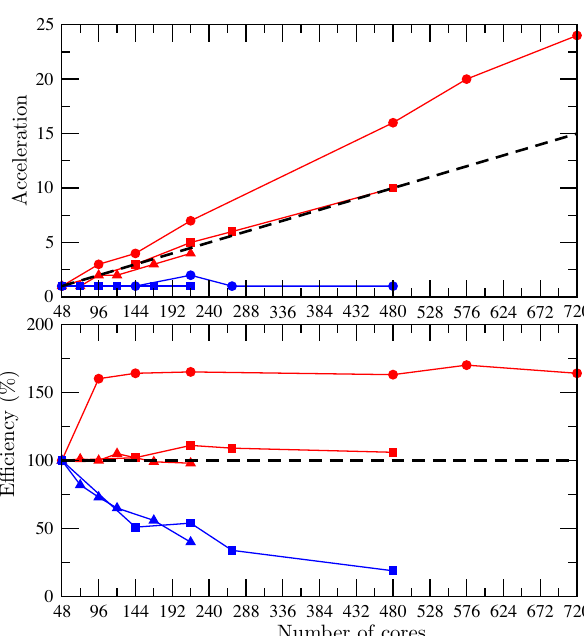
Fig. 3. Acceleration (top) and efficiency (bottom) for strong scalability experiments using the block preconditioner for meshes with (red • ) 2 . 400 × 10 6 nodes, (red (cid:4) ) 1 . 142 × 10 6 nodes and (red N ) 0 . 708 × 10 6 nodes, and the MUMPS solver for meshes with (blue (cid:4) ) 1 . 142 × 10 6 nodes and (blue N ) 0 . 708 × 10 6 nodes. The dashed line indicates a theoretical efficiency of 100 %.